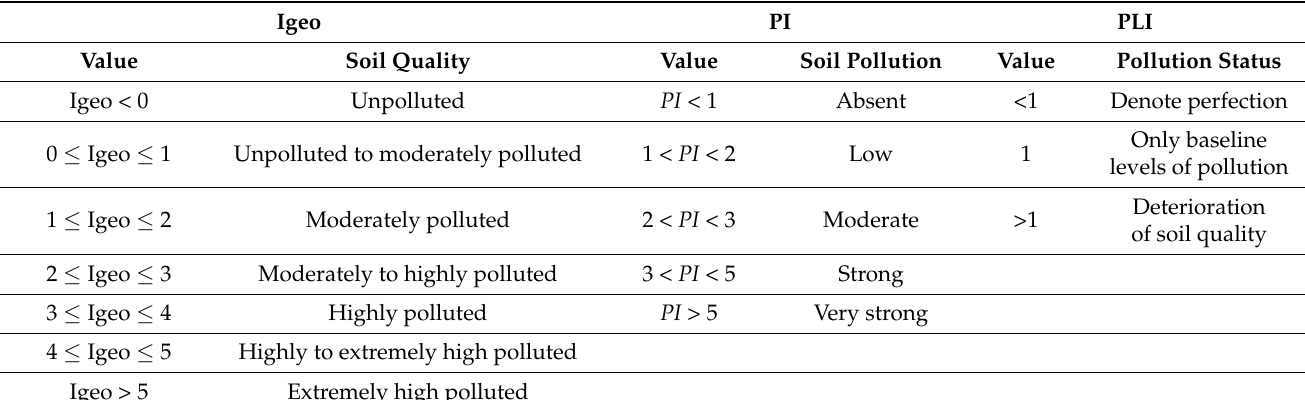
Table 2. Interpretation values and classes of used indexes